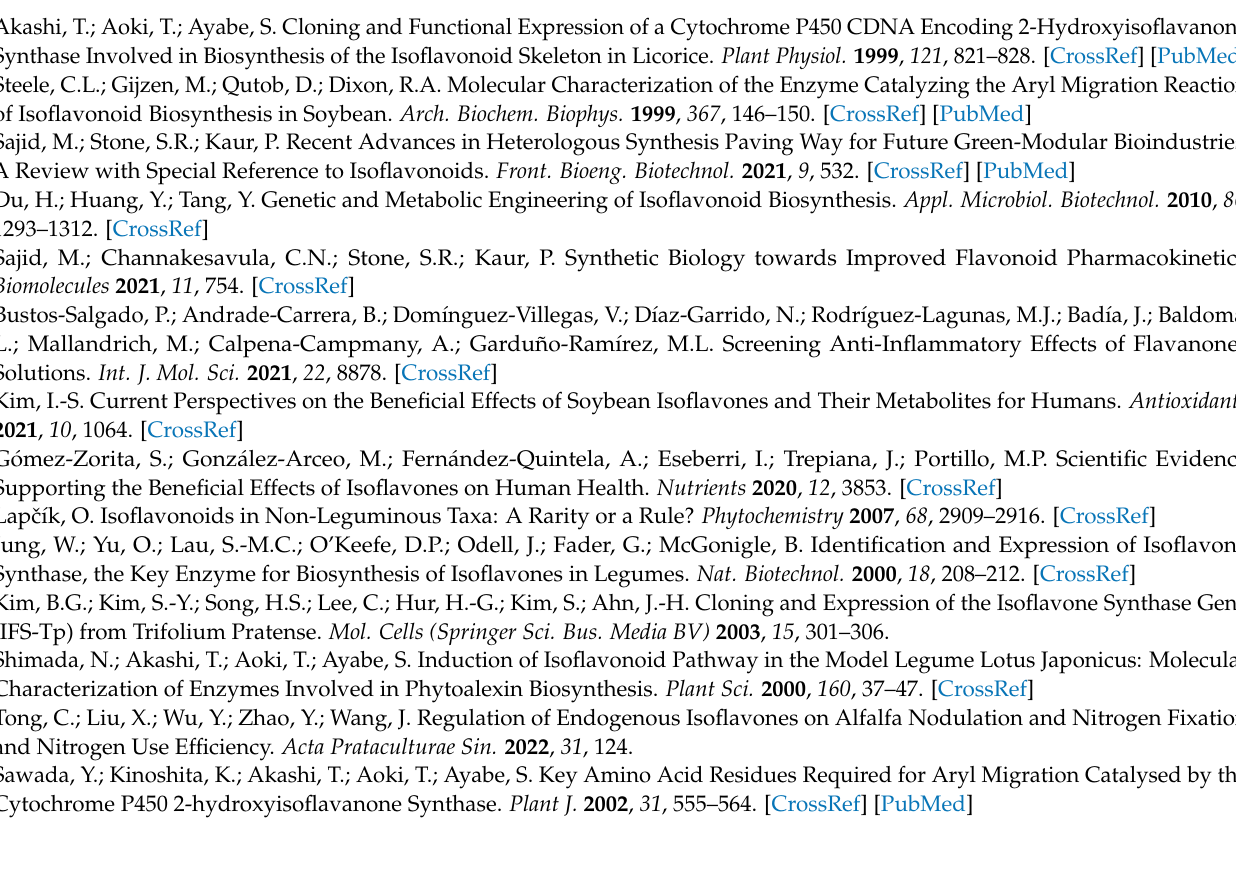
efficiency. The table represents the amino acid sequence of the loop/ β -hairpin region (Amino acids numbers are based on the G. echinata sequence). Figure S5: Comparison of protein homology models homology models overlap with each other and (G) homology models overlapped with the template (PDB: 5ylw). Table S1. IFS amino acid sequences were used in this study. Table S2. IFS clade grouping based on phylogenetic analysis. Table S3. Functionally characterised Isoflavonoids synthase (IFS). Table S4: Protein modelling parameters of selected IFS sequences on SWISS-MODEL server. Table S5: Protein modelling parameters of selected IFS sequences on the Alphafold server. Table S6: Protein homology modelling parameters of selected IFS sequences from A. membranaceus , B. vulgaris , L. culinaris , M. truncatula , T. pratense , V. angularis and G. echinata .